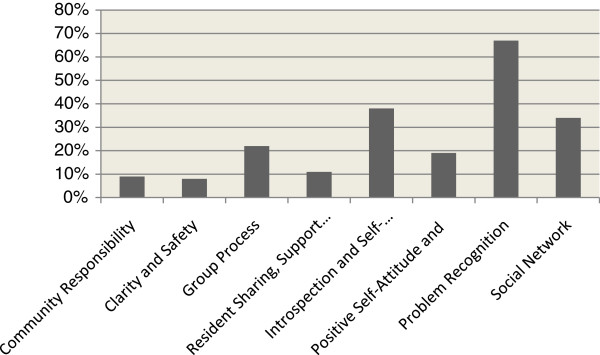
Proportion of respondents reporting low scores for the eight DCI subscales.